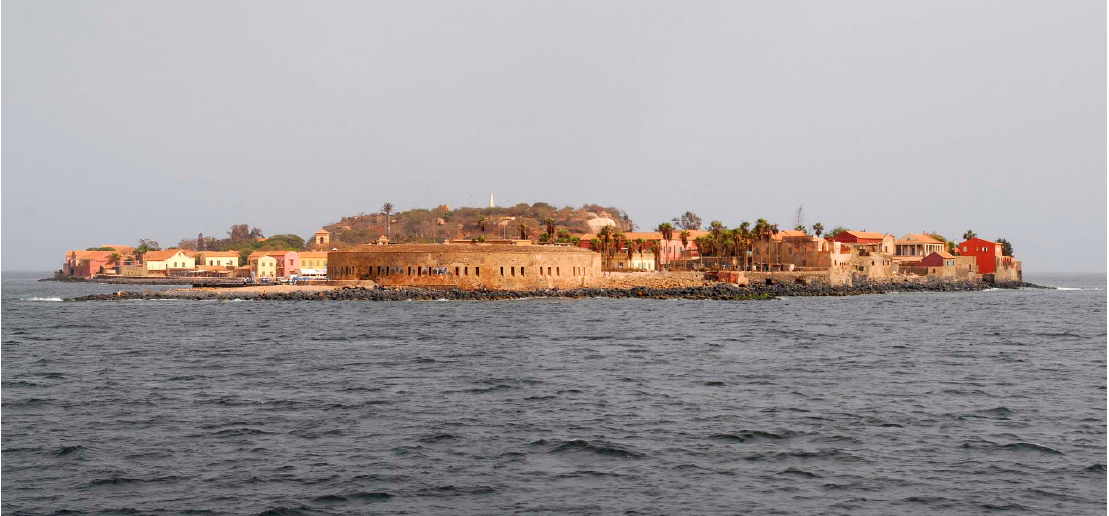
Figure 1. Ile Gorée , Senegal. Creative Commons (photo by Antonin Rémond). Figure 1. Ile Gor é e , Senegal. Creative Commons (photo by Antonin R é